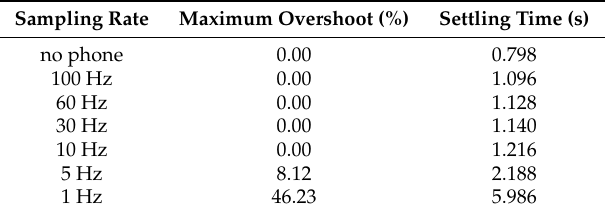
Table 3. Motor response performance using the digitally redesigned PD-control